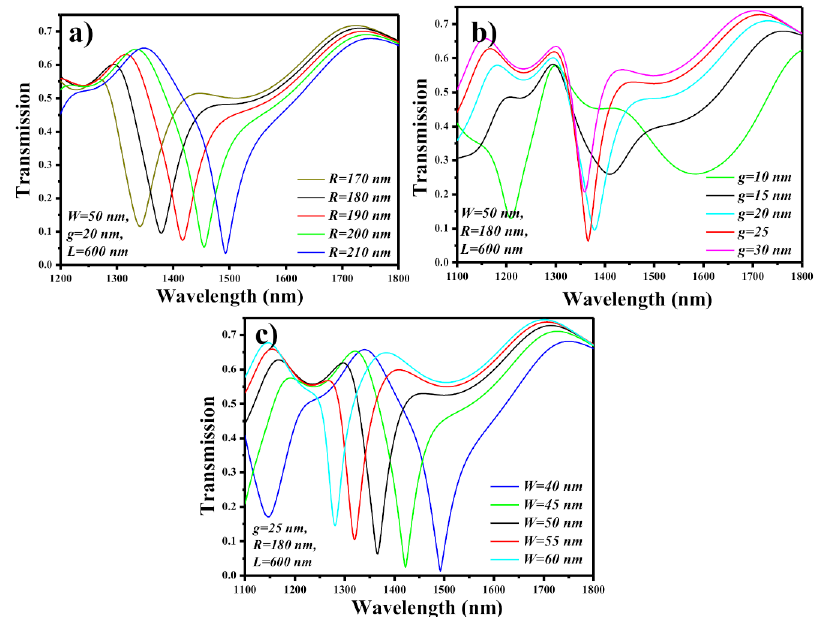
Figure 4. Optimization of standard racetrack cavity: ( a ) R variation, ( b ) g variation, ( c ) W variation.